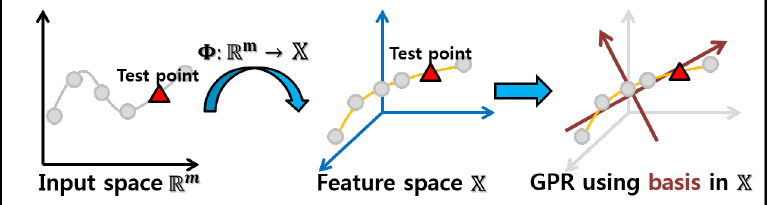
Figure 1. A conceptual illustration of the kernel subspace learning in Gaussian process regression (GPR) [23] (reproduced with permission from Eunwoo Kim, Sungjoon Choi, Songhwai Oh, A Robust Autoregressive Gaussian Process Motion Model Using l 1 -Norm Based Low-Rank Kernel Matrix Approximation; published by IEEE 2014), where we perform GPR in the low-dimensional feature